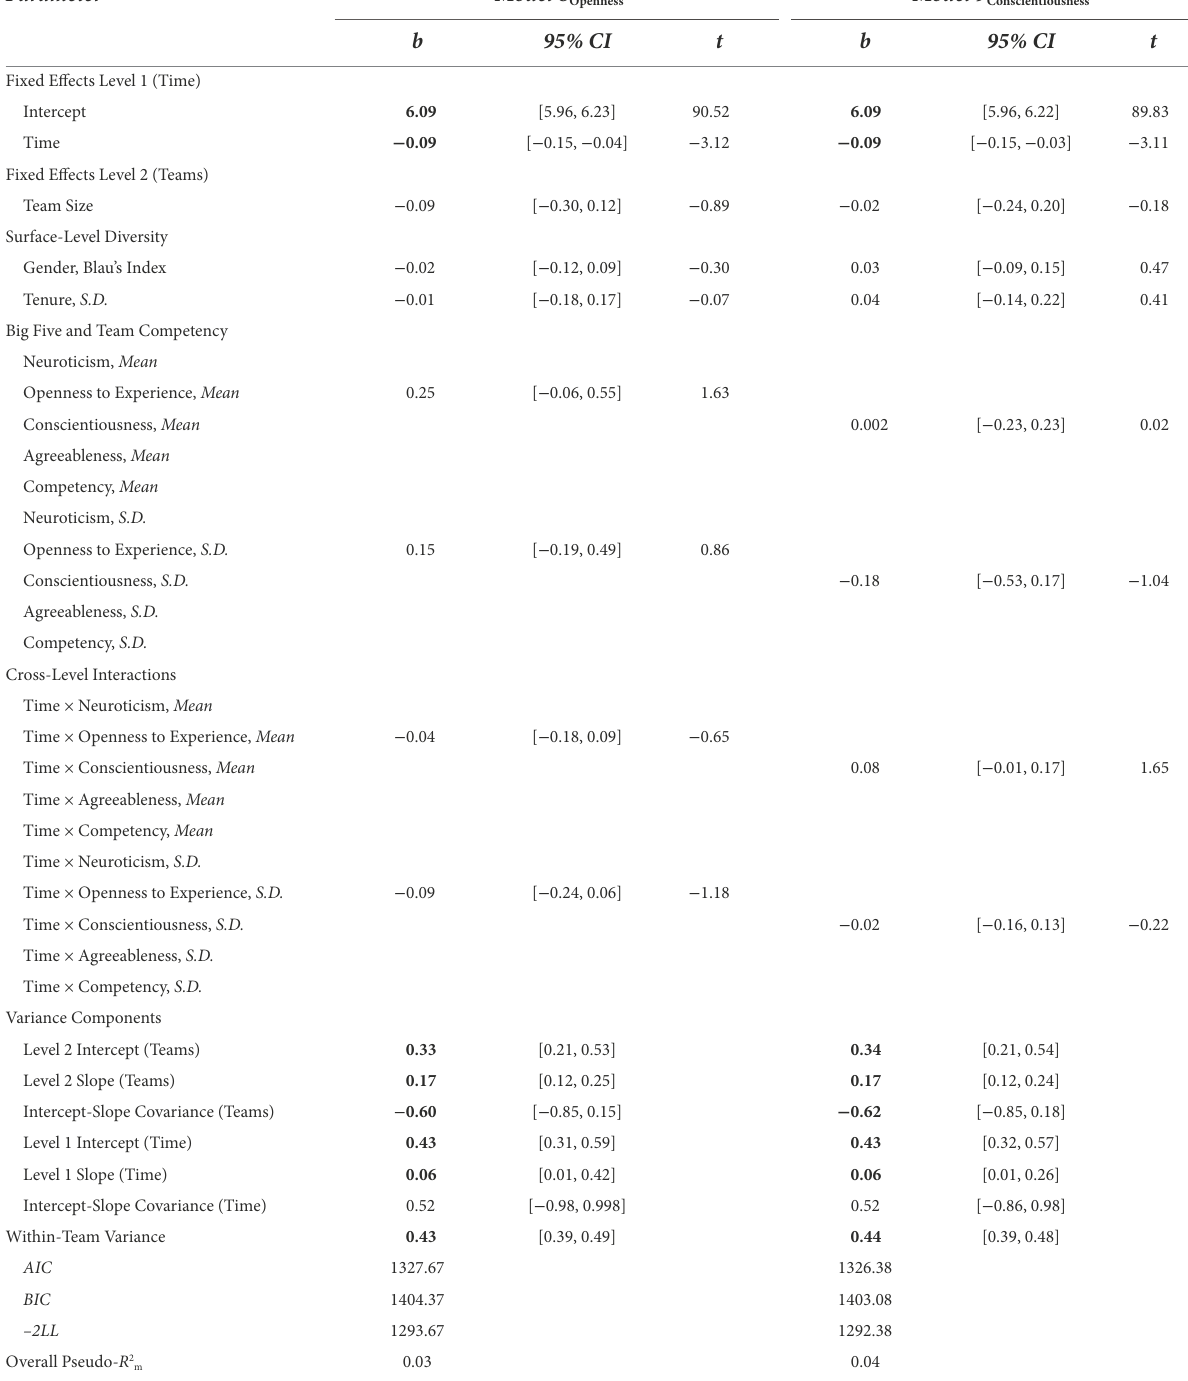
Table 4 Linear Growth Curve Model ( n = 699 measurements nested in three time points, in 233 members in 61 teams) for changes in team psychological safety predicted by team personality and competency (Models 8 and 9).